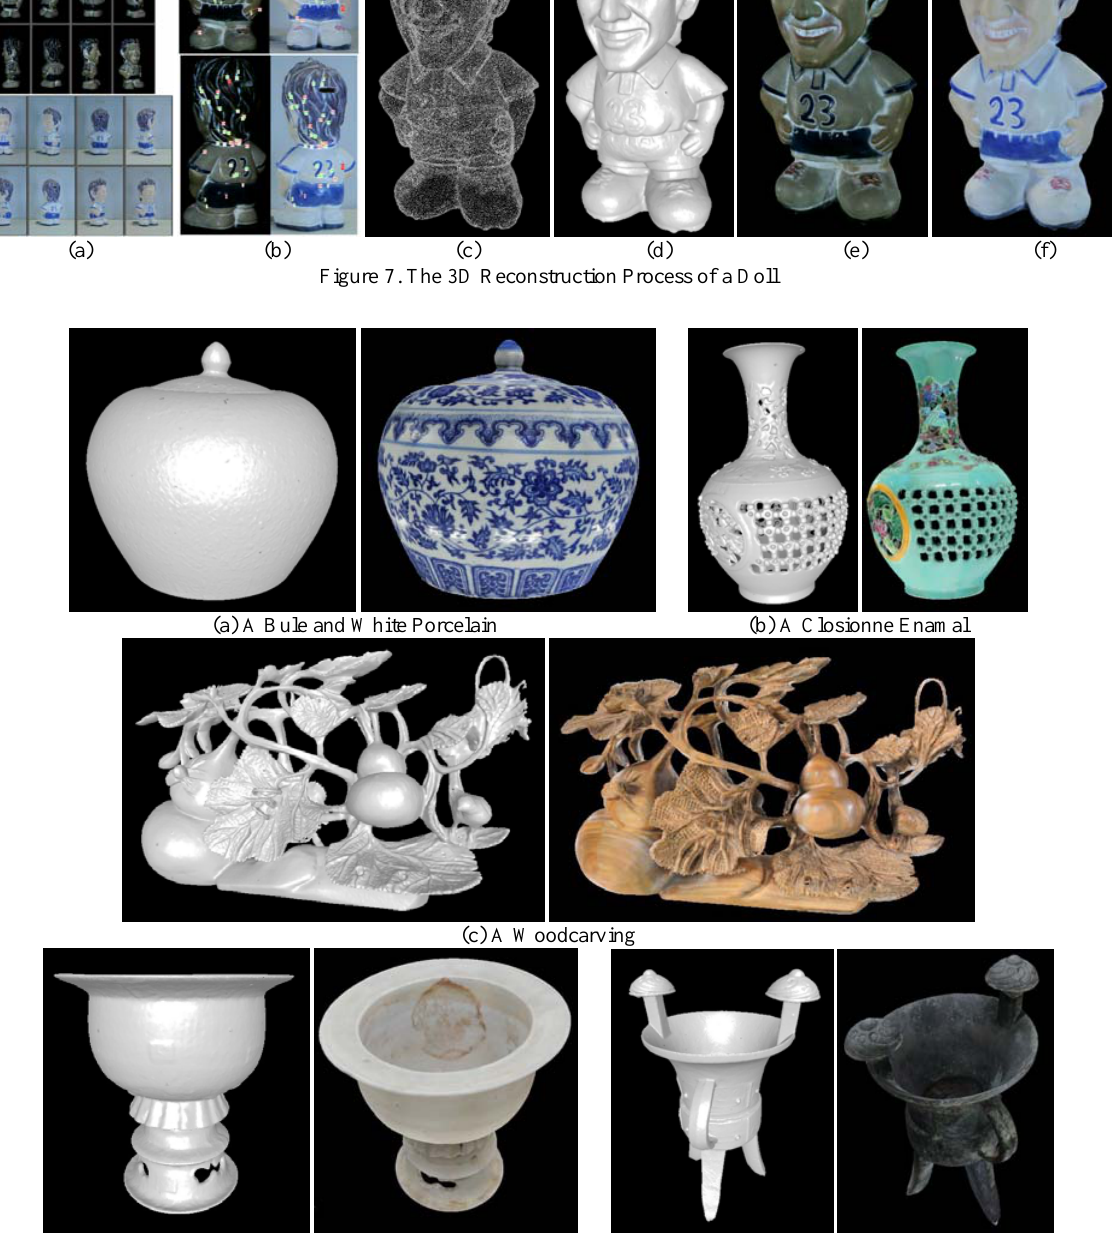
Figure 8. The 3D Reconstruction Results of Some art and craft goods and cultural relics in